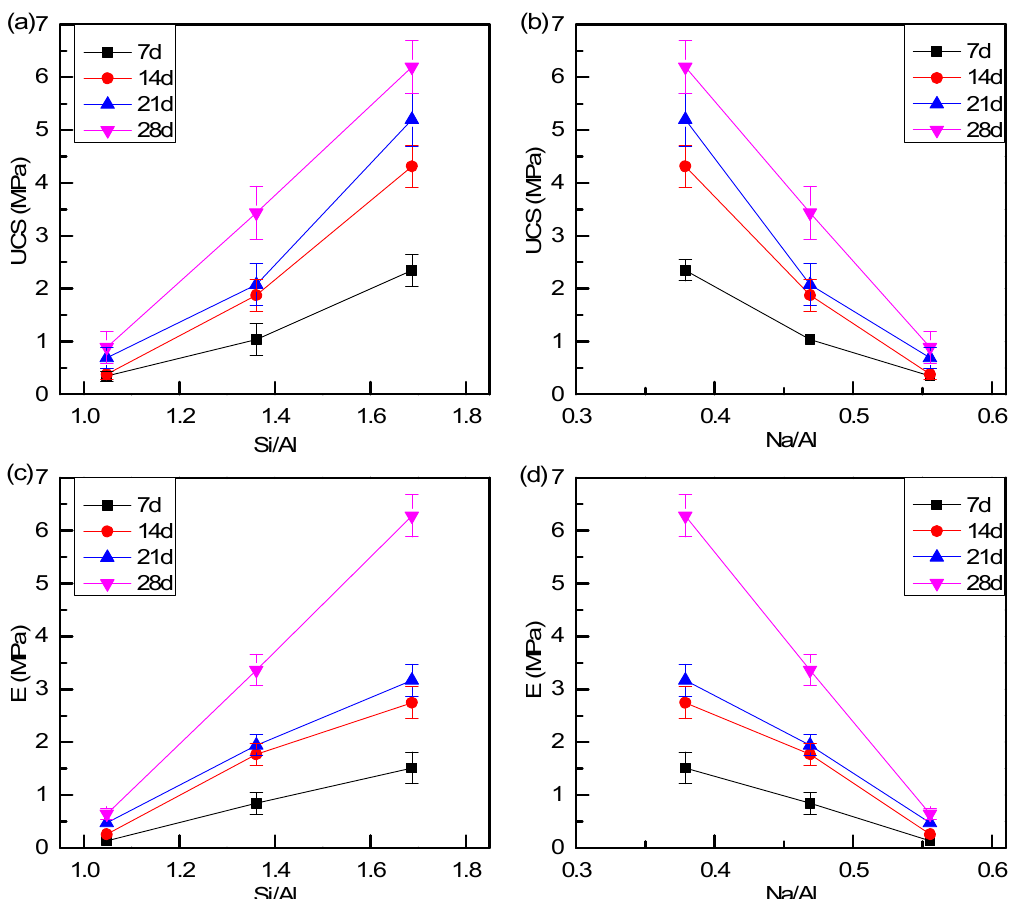
Figure 6. The unconfined compressive strength of the end products at different (a) Si/Al and (b) Na/Al ratios; and the Young’s modulus ( E ) at different (c) Si/Al and (d) Na/Al ratios.